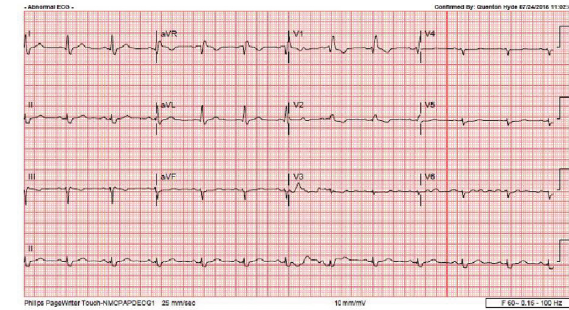
Figure 4: Immediately after seizure (postop